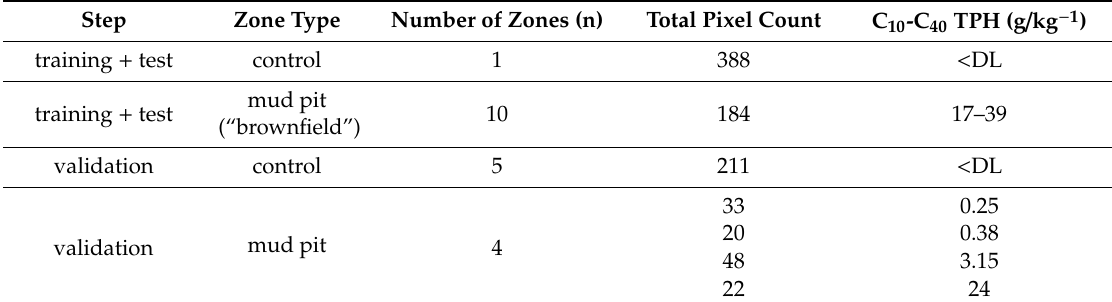
Table 1. Description of the sites used for testing and validating the methods. ( < DL, below detection